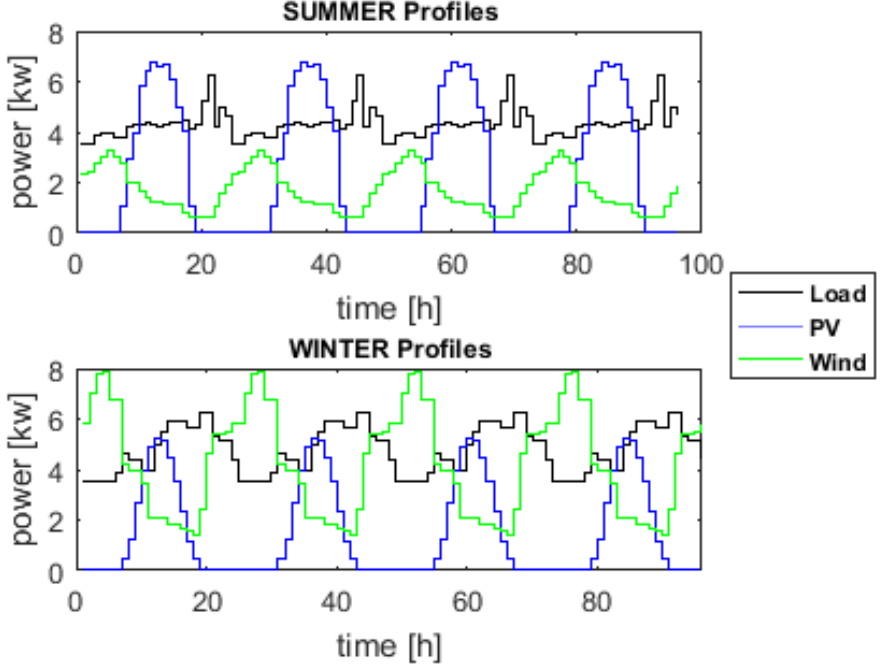
Figure 2. Forecasted profiles of PV and wind generators, and load